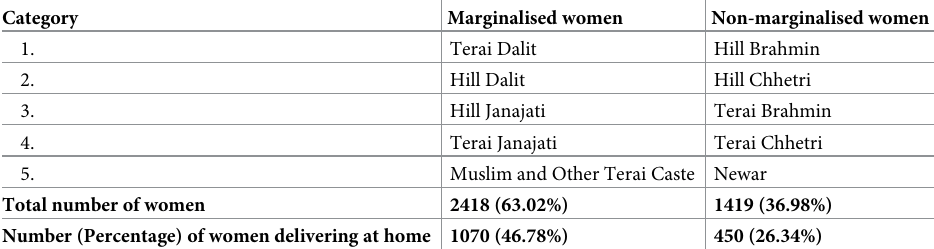
Table 1. Categories defining marginalised and non- marginalised.